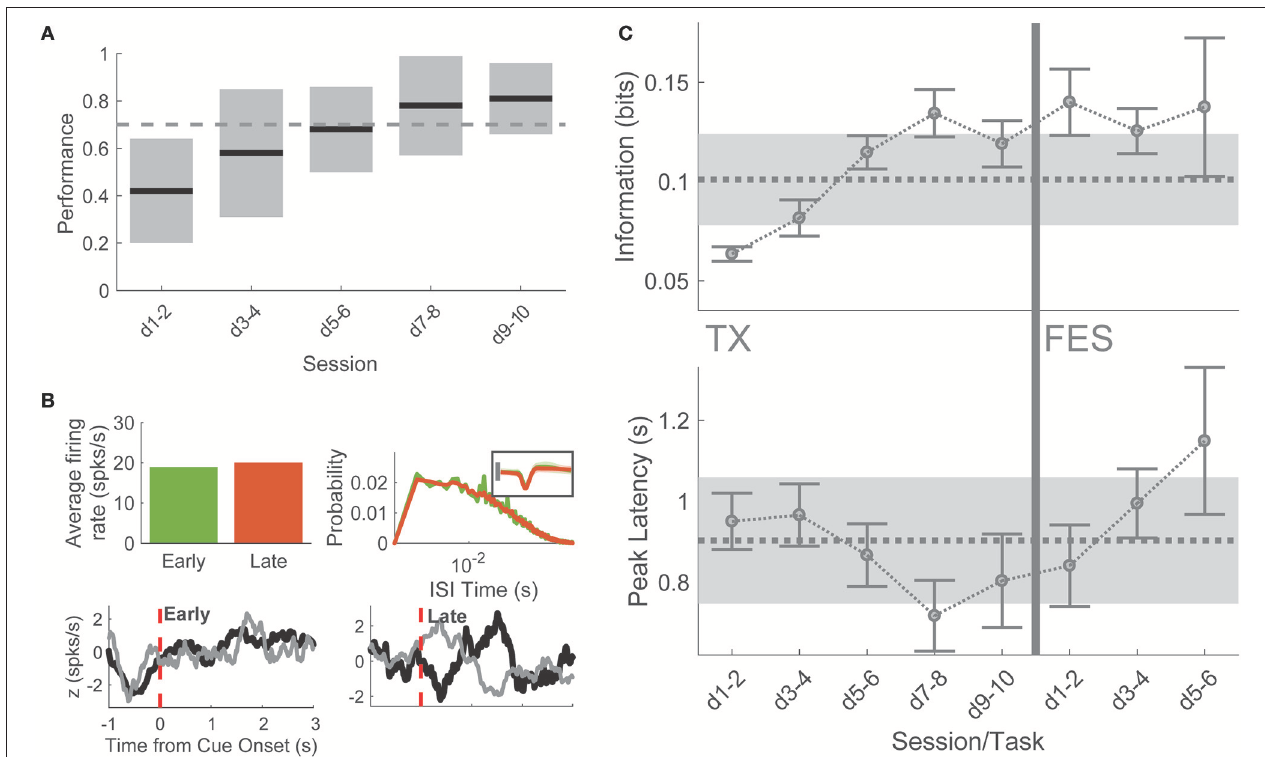
FIGURE 3 | Post-TX task. (A) Performance in the task was initially poor for several but returned to baseline levels on days 7–8 and remained high thereafter. (B) Single neuron example of metrics used to compare early/late-TX information. This neuron was determined to be putatively the same sampled on days 1 and 9 of BMI-tx for one animal. There was no difference in the overall firing rate of the neuron (top left), no quantitative difference in interspike interval (top right), and no duration information encoded (bottom left). After relearning and reaching criterion performance, this neuron modified its firing such that significant information about